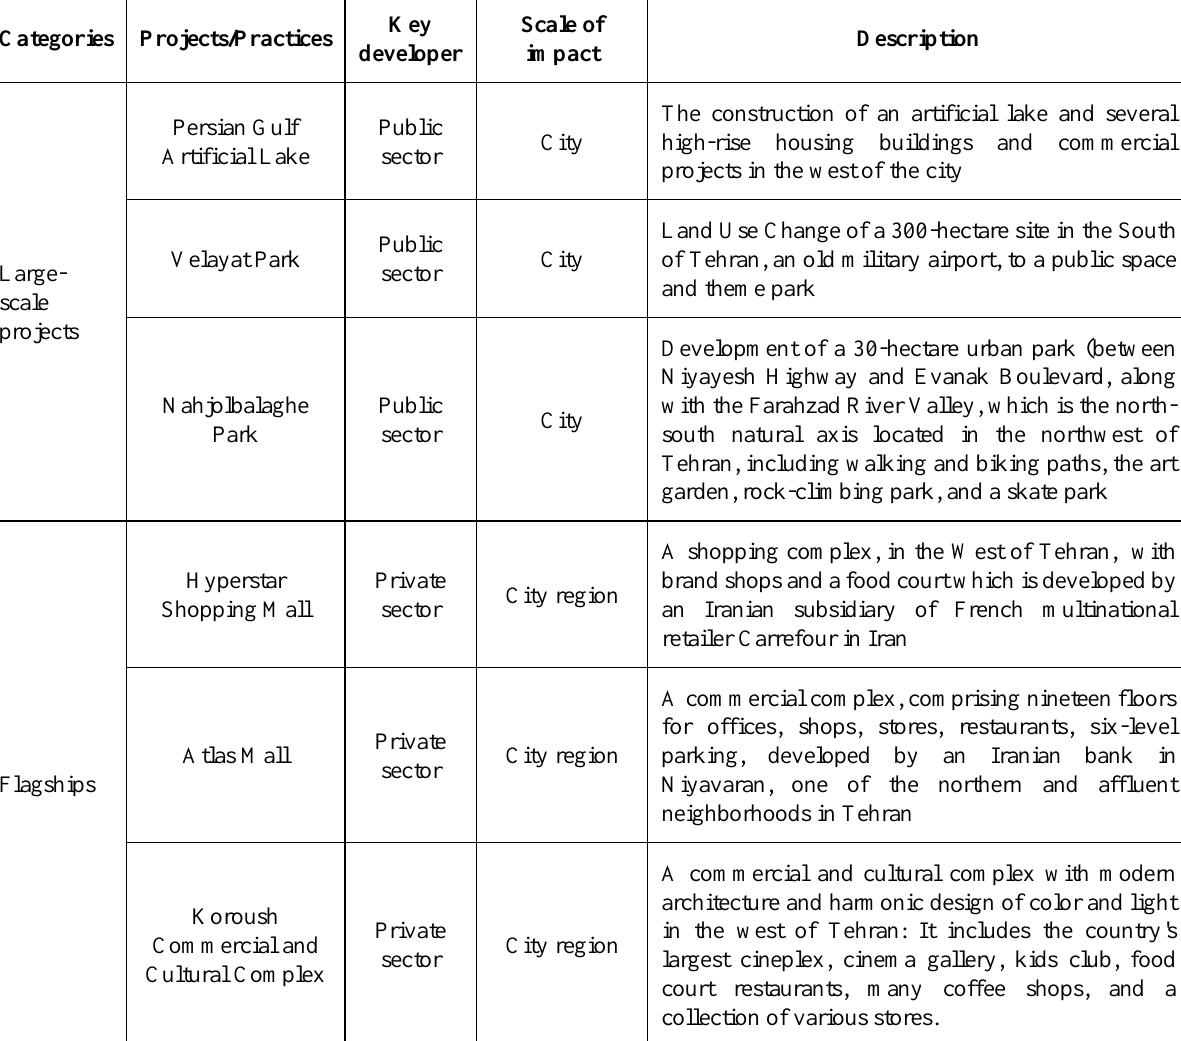
Table 3. The list of projects and practices in Tehran, selected for